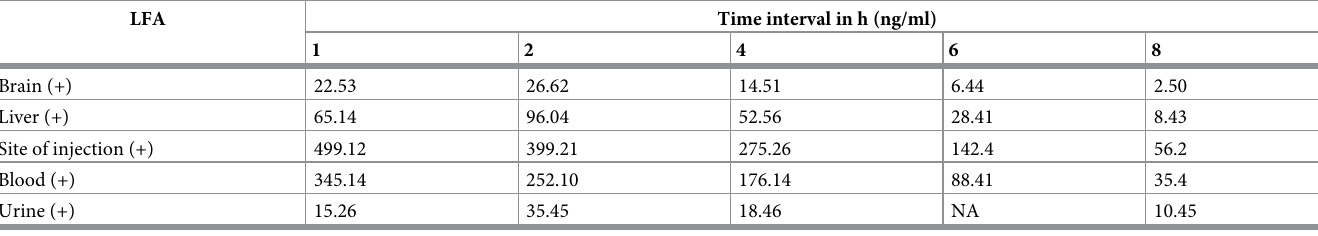
Table 1. Evaluation of LFA and ELISA test for comparing the results from experimentally envenomed samples.